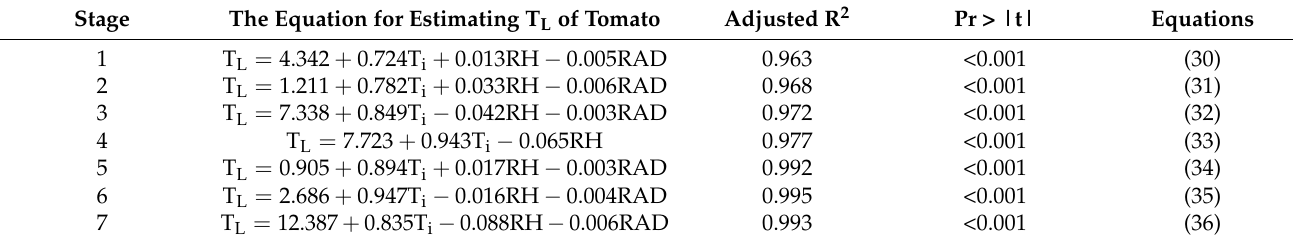
Table 6. Multiple regression model for estimating T L by growth